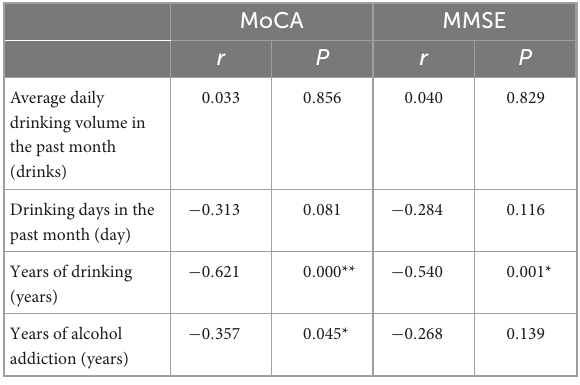
TABLE 3 Correlation between the scores of MoCA and MMSE and drinking in